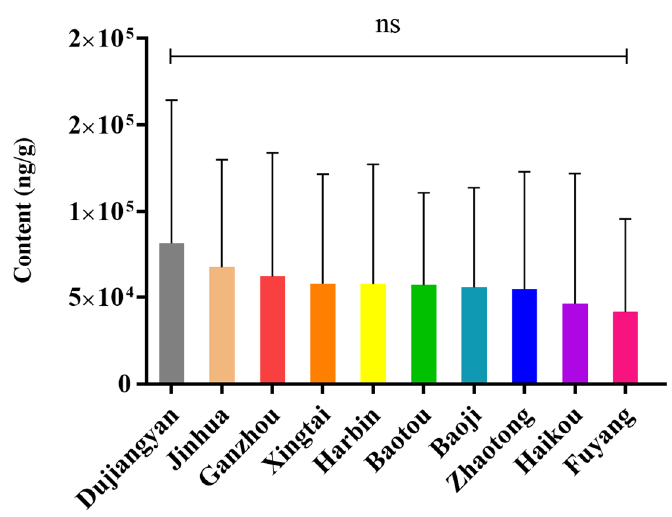
Figure 3. Total withanolide content in each production area of D. metel L. (ns no significance).